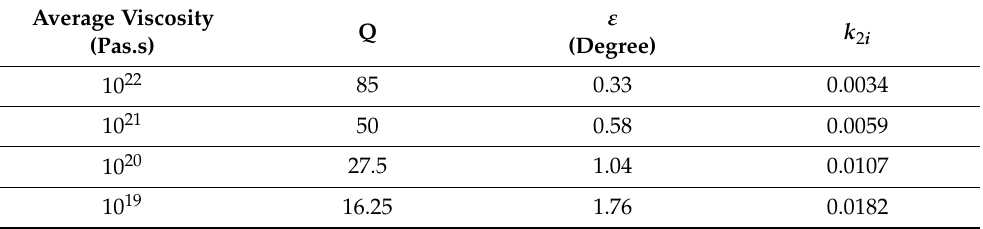
Table A2. k 2 imaginary part values and their associated tidal dissipation factor Q and tidal phase lag angle ε values. Each Q value corresponds to the median value computed for four of Venus’ average mantle viscosity values (see Figure 4 in [14]). The tidal phase lag angle is derived as ε ∼ 1/2 Q and the k 2 imaginary part as (cid:2193) (cid:2779)(cid:2191) (cid:3404) (cid:2193) (cid:2779)(cid:2200) , with k 2r being the k 2 real part (taken here as 0.295 [13]).